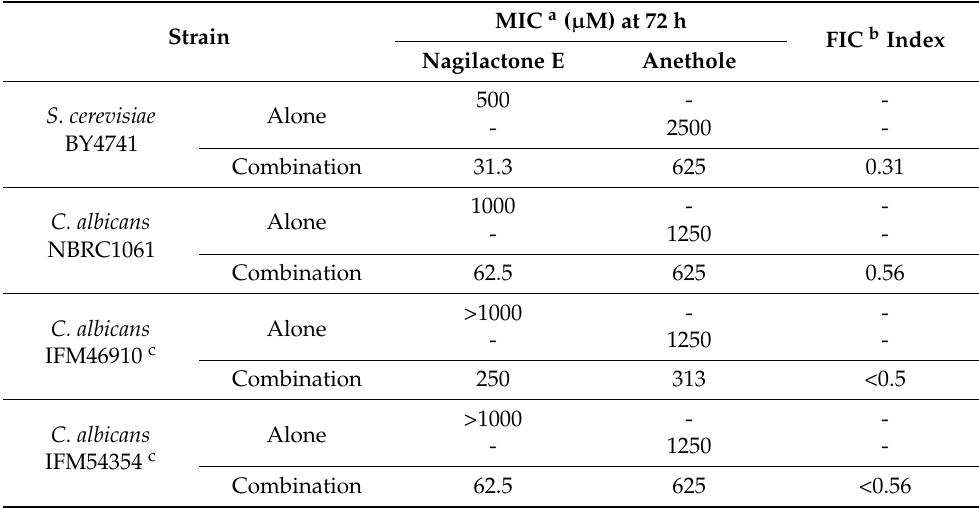
Table 1. MICs of nagilactone E, anethole, or their combination against S. cerevisiae or C. albicans.